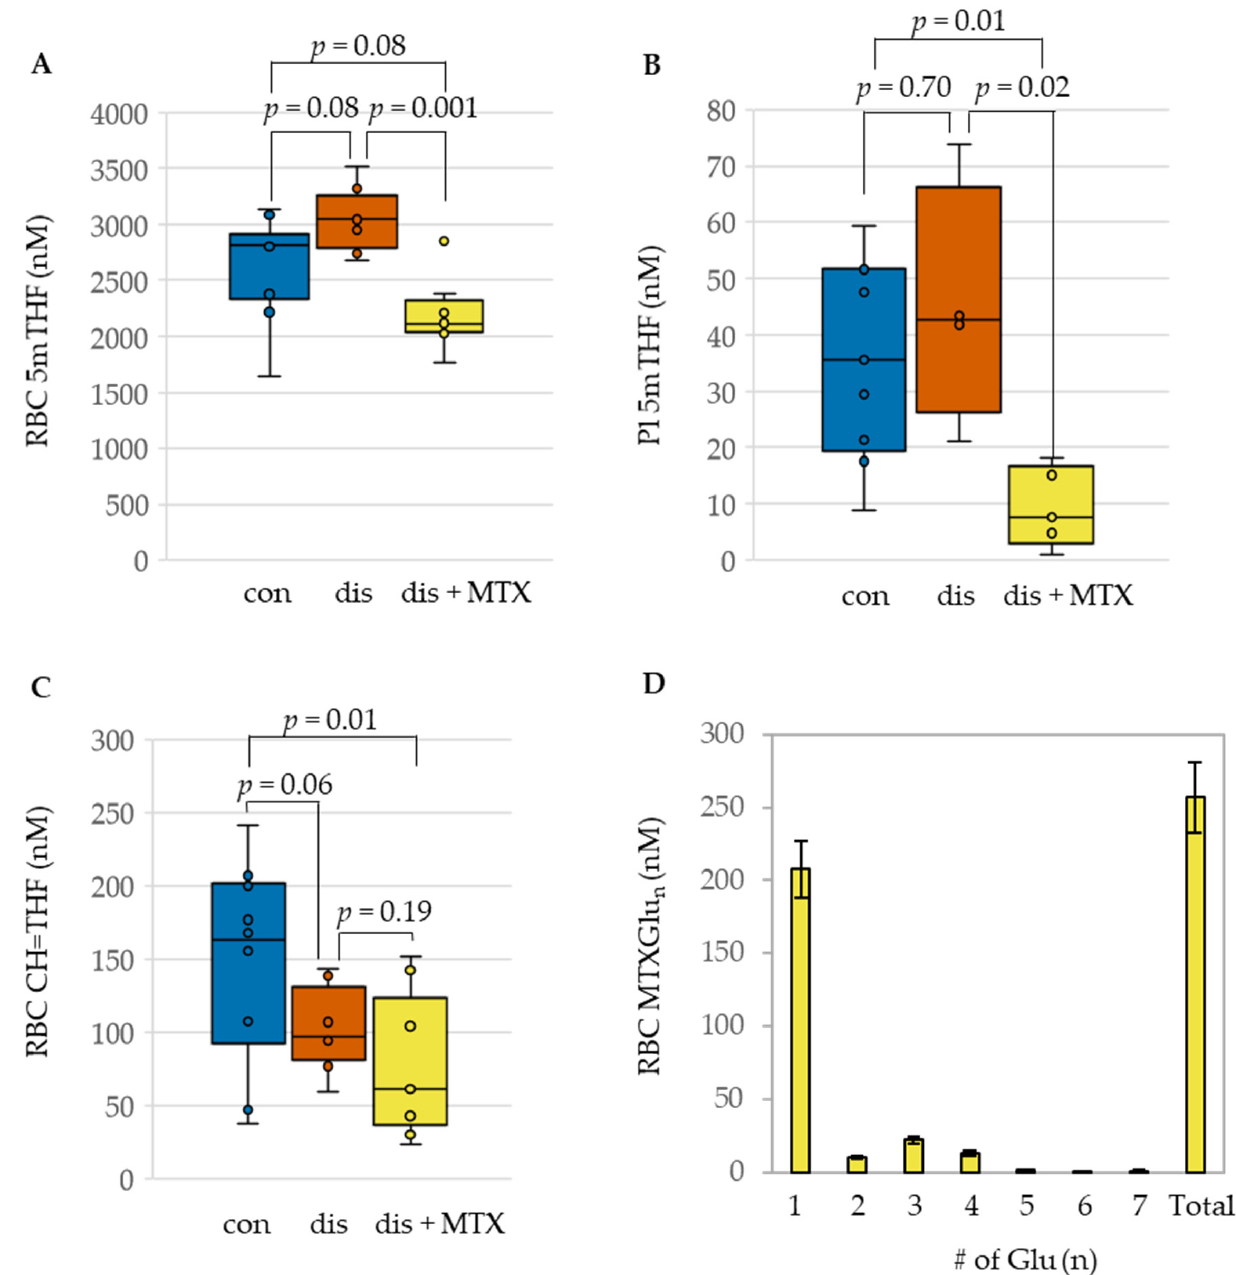
Figure 2. Influence of MTX treatment on folate concentrations and RBC disposition of MTX in the CIA mouse model. Comparison of ( A ) RBC 5mTHF, ( B ) Plasma 5mTHF, ( C ) RBC CH=THF, and ( D ) polyglutamate distribution of RBC MTX in healthy control (con; blue; n = 10), CIA disease mice (dis; orange; n = 8), and CIA disease mice treated with MTX (dis + MTX; yellow; n = 9).